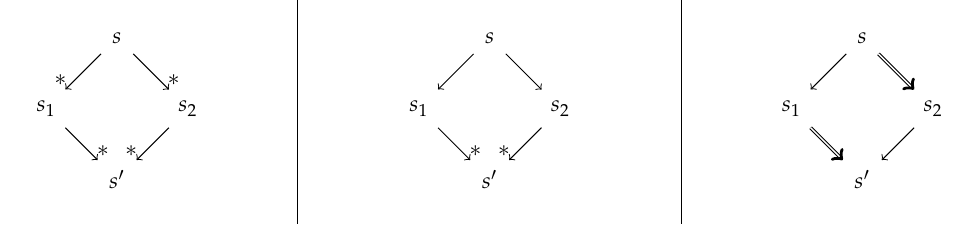
Figure 2. Confluence, local confluence, and commutation.